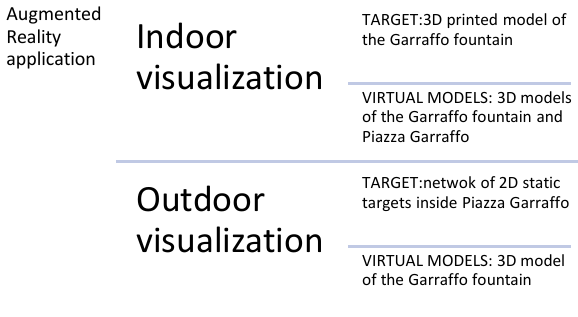
Figure 10. Schema of the 2 developed experimentations.